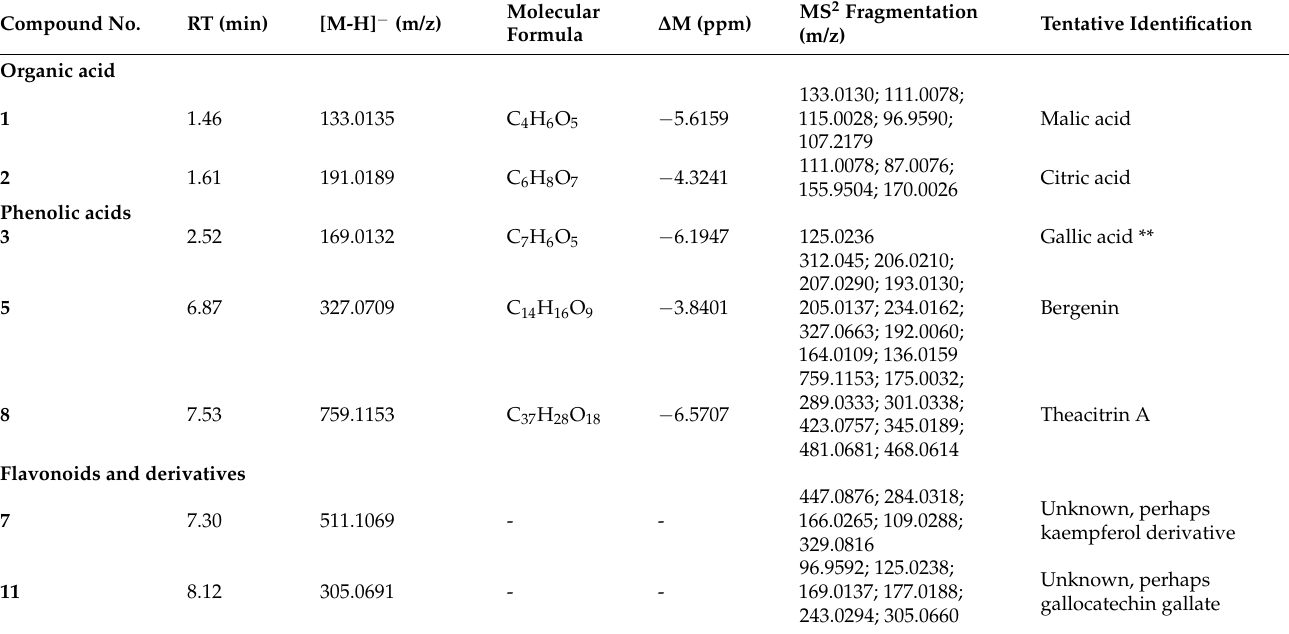
Table 6. Non-anthocyanin phenolic compounds (tentatively) identified in the aqueous extracts from Syzygium aqueum